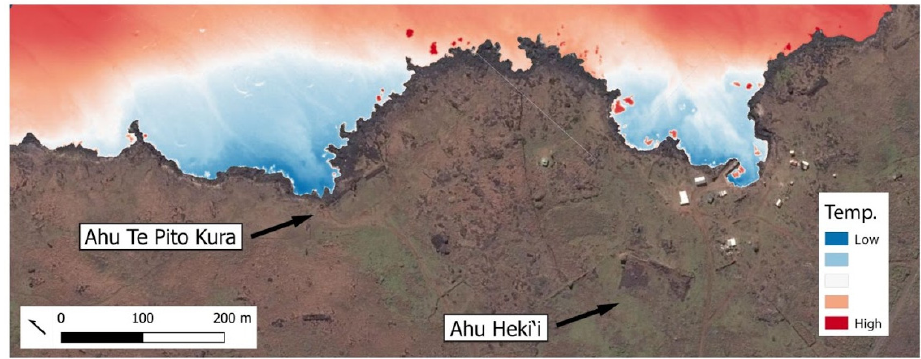
Figure 5. Thermal image of submarine groundwater discharge in the Hanga Ho‘onu area, showing Ahu Heki‘i and Ahu Te Pito Kura.